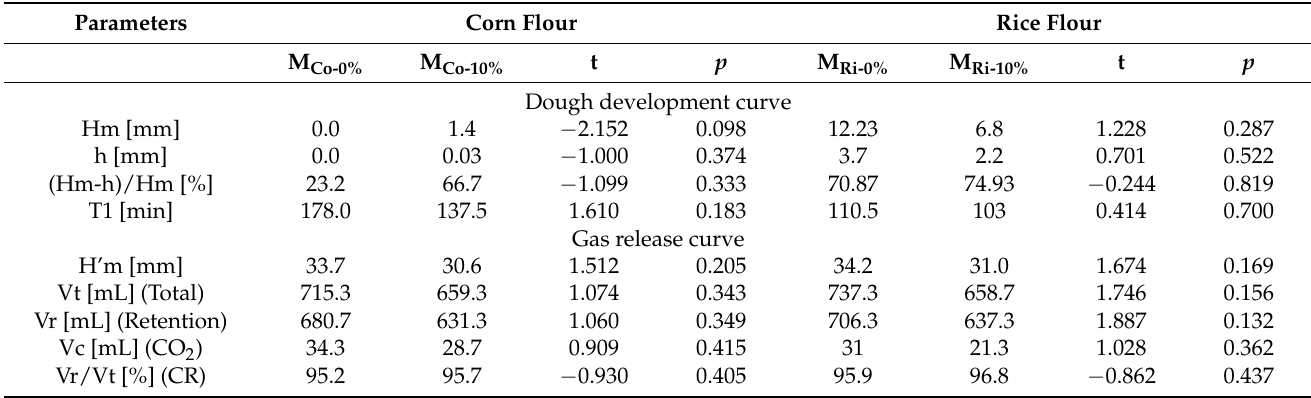
Table 5. Results of t-test for corn and rice flour without (0%) and with the addition of 10% of edible